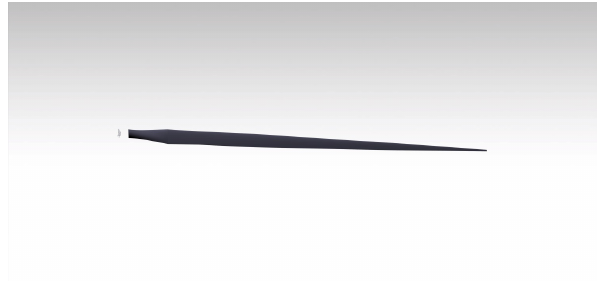
Figure 4. 3-D model of the blade.